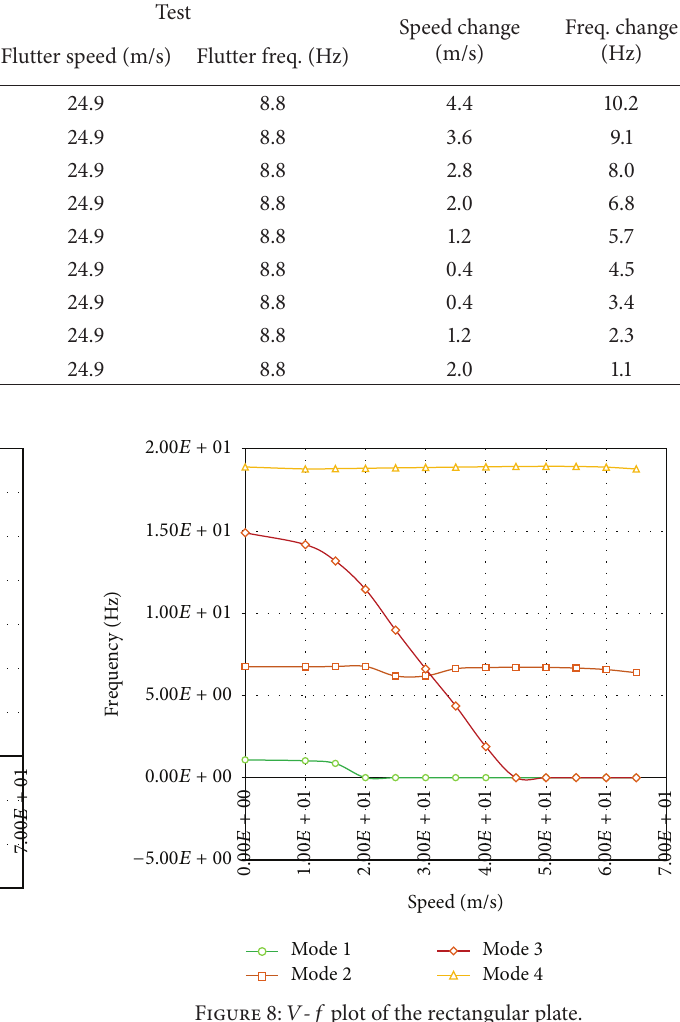
critical conditions of the fighter aircraft. Then, it is better to use 𝑔 -method results for the flutter